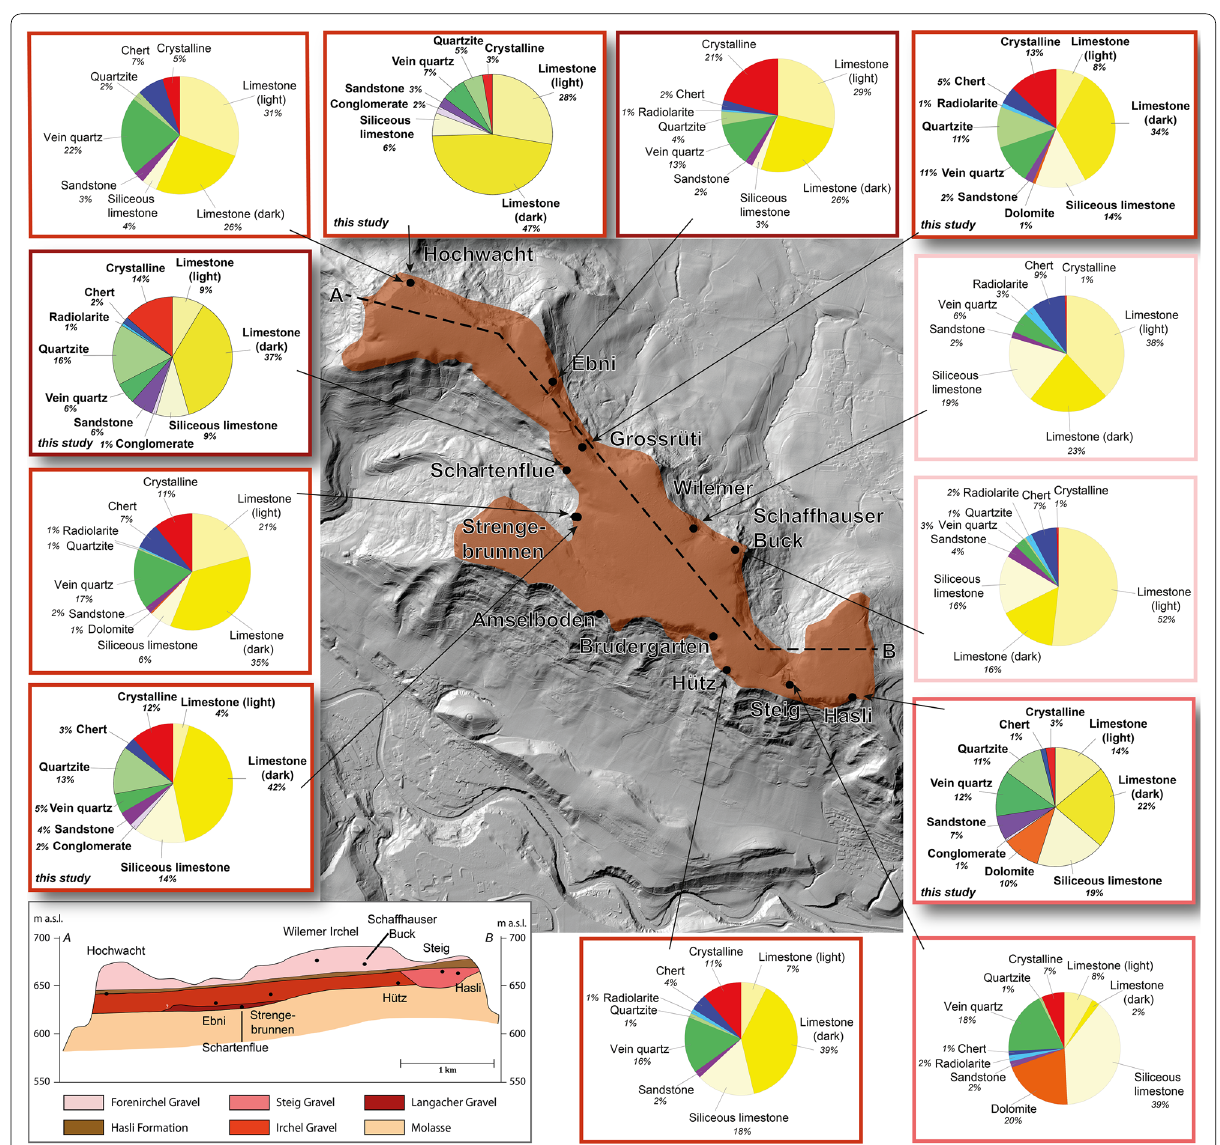
Fig. 8 Clast petrography of the gravels analysed at Irchel and their locations on the map and the cross-section A–B (this study and after Claude et al., 2019). Please note that colour scale on the frames of the pie charts refers to the morphostratigraphy and the formations proposed by